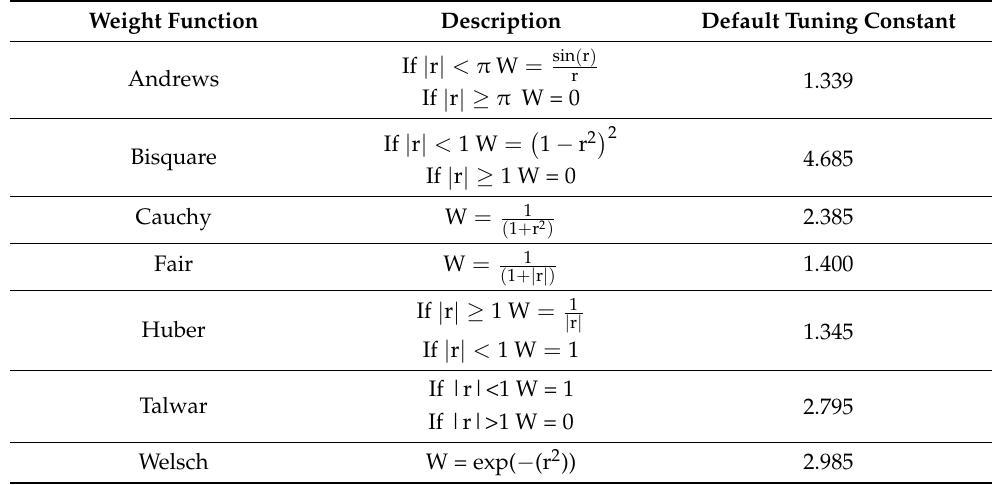
Table 4. Robust modeling functions